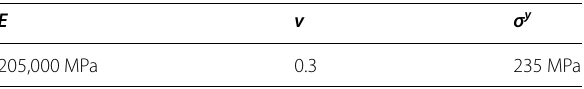
Table 2 Material constants of bolt and metal washer